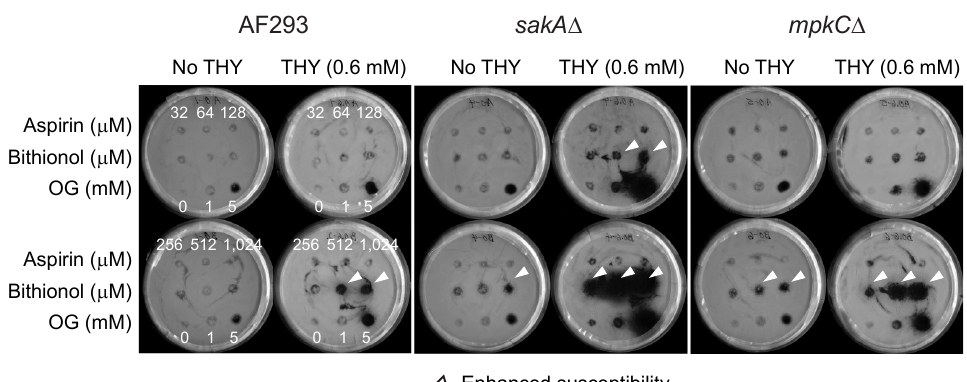
Figure 2. Enhancement of antifungal activity of bithionol by thymol tested in A. fumigatus . THY, thymol; OG, octyl gallate (positive control).